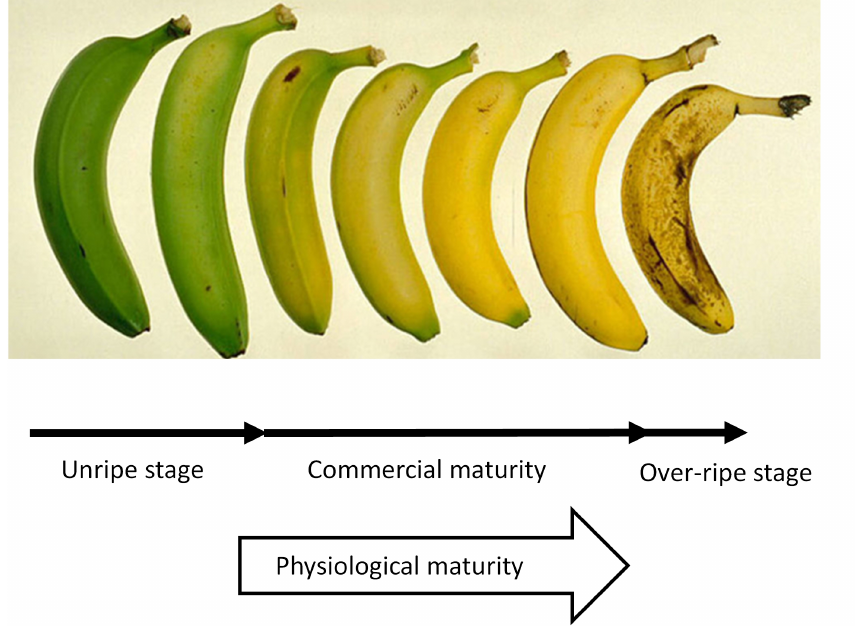
Figure 1. Different stages of fruit